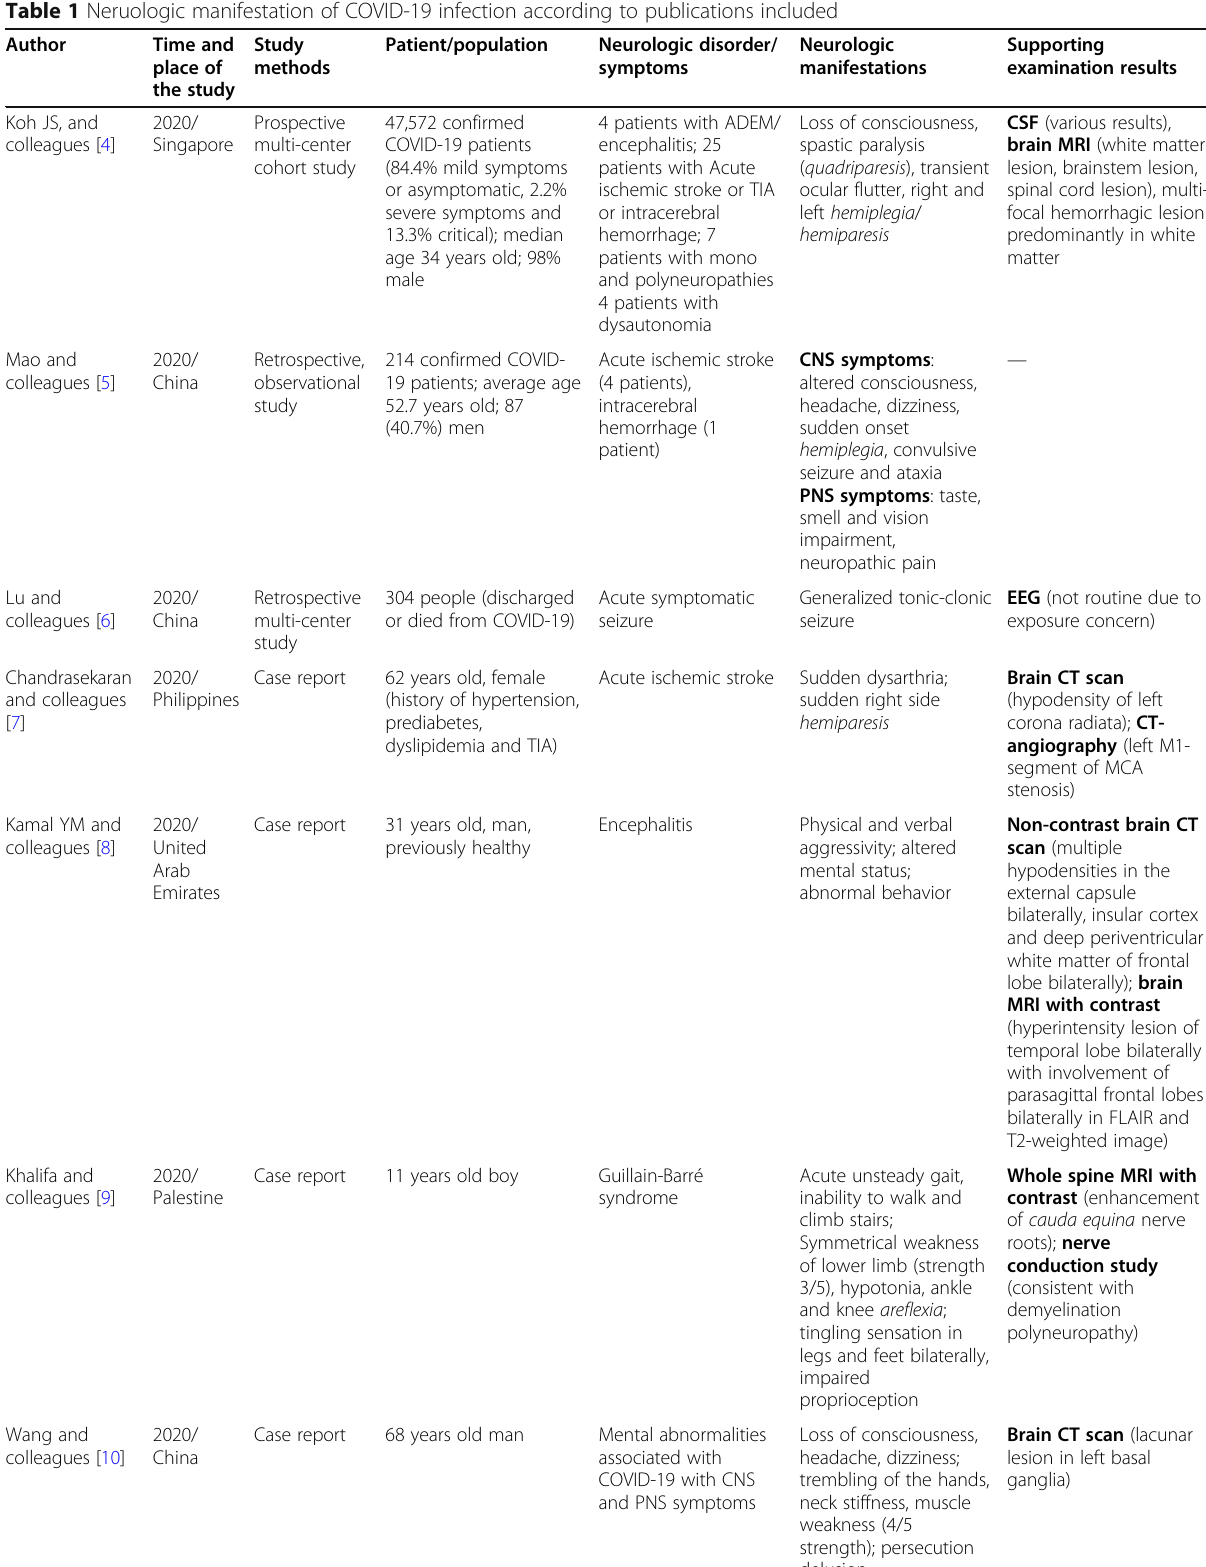
Table 1 Neruologic manifestation of COVID-19 infection according to publications included